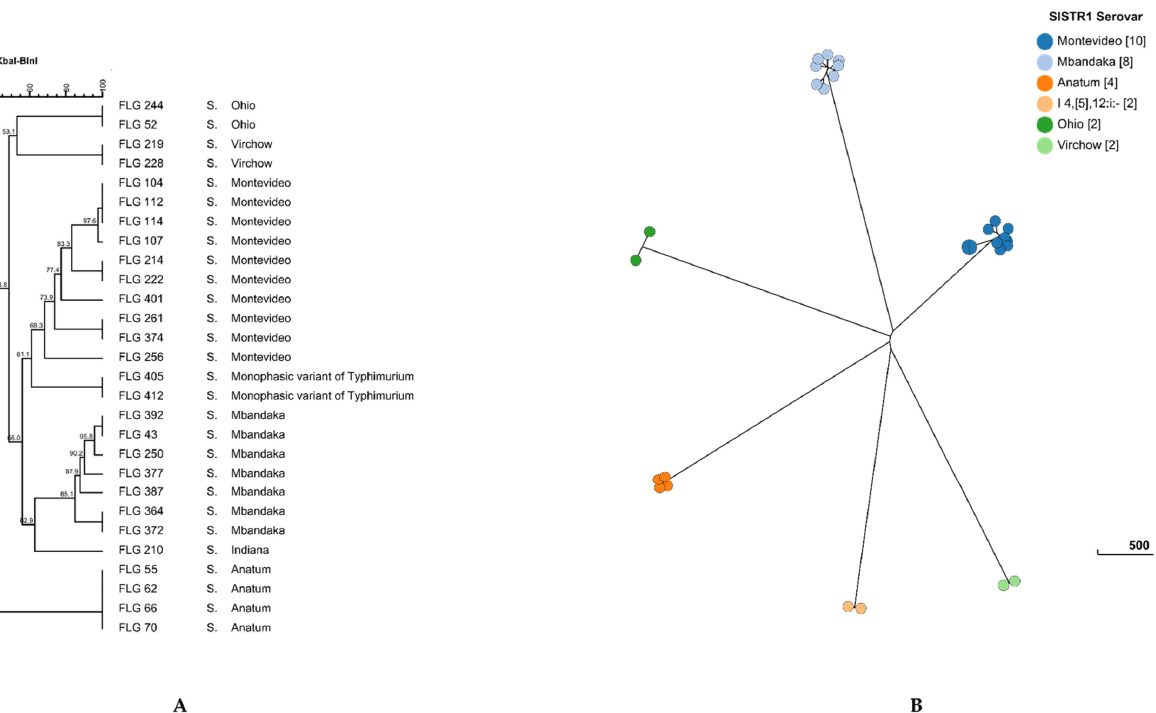
Figure 3. Dendrogram of pulsed-field gel electrophoresis (PFGE) cluster analysis using the Xba I and Bln I restriction enzymes ( A ) and cgMLST Grape Tree ( B ) of selected isolates of Salmonella .